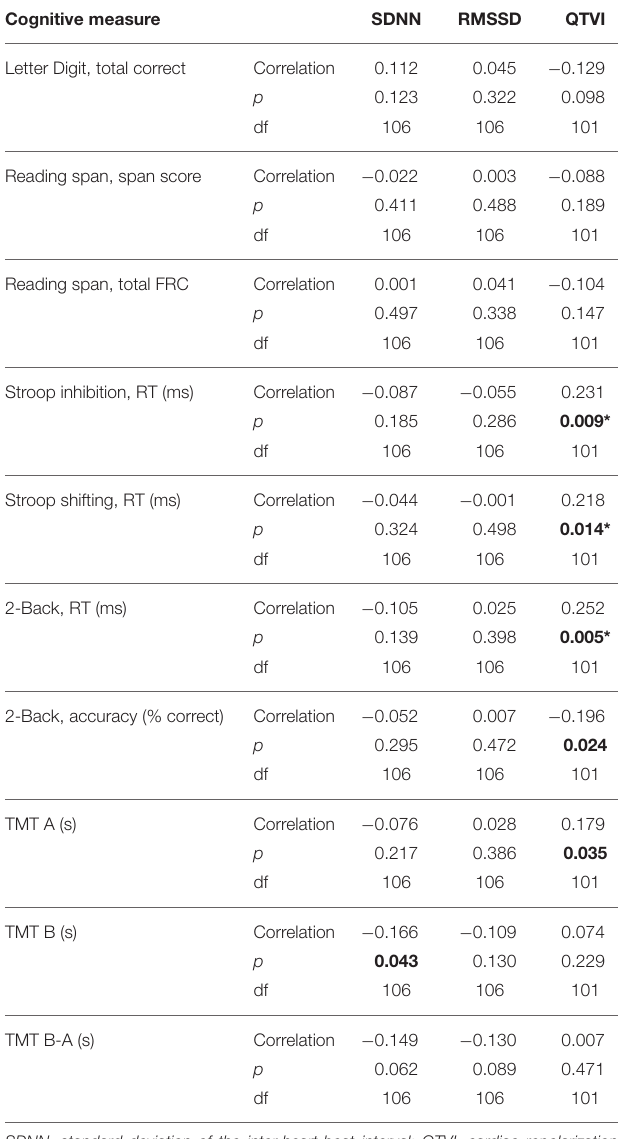
TABLE 3 | Partial correlations between cognitive measures and HRV measures, adjusting for age and sex (1-tailed sign. testing). Cognitive measure